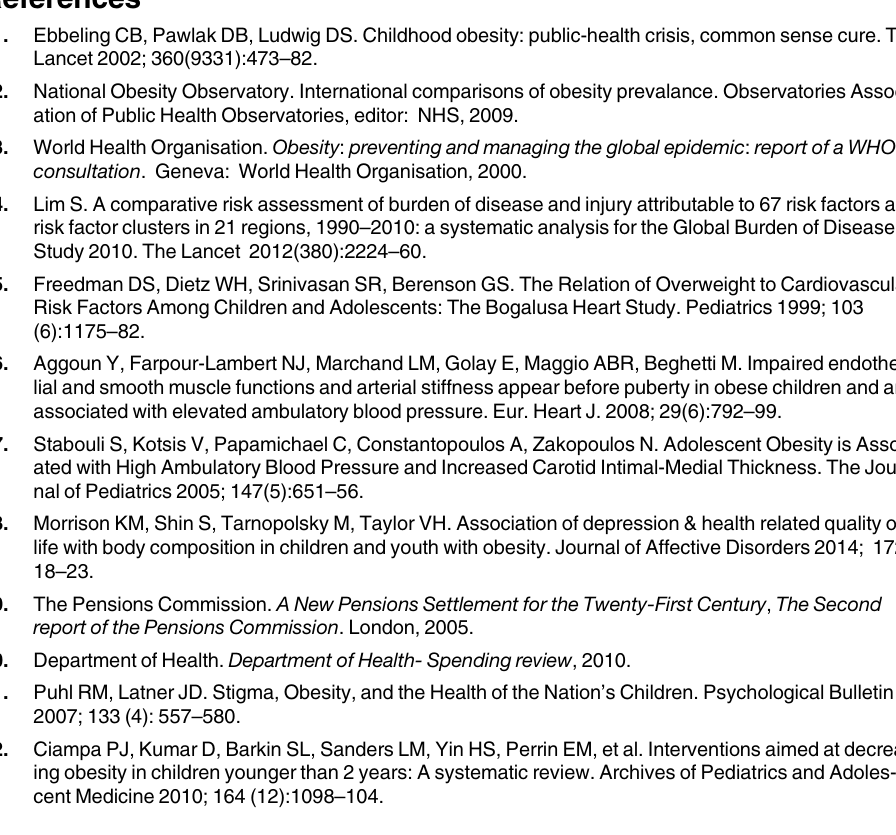
S1 Table. Outcomes in which a significant (p < 0.05) improvement was seen compared to